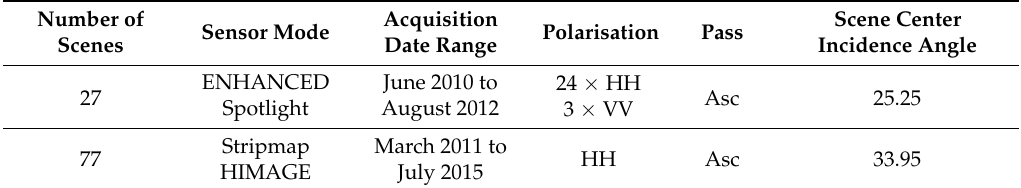
Table 1. CSK data characteristics. For precise characteristics of all data, see Table S1 in the Supplementary Data